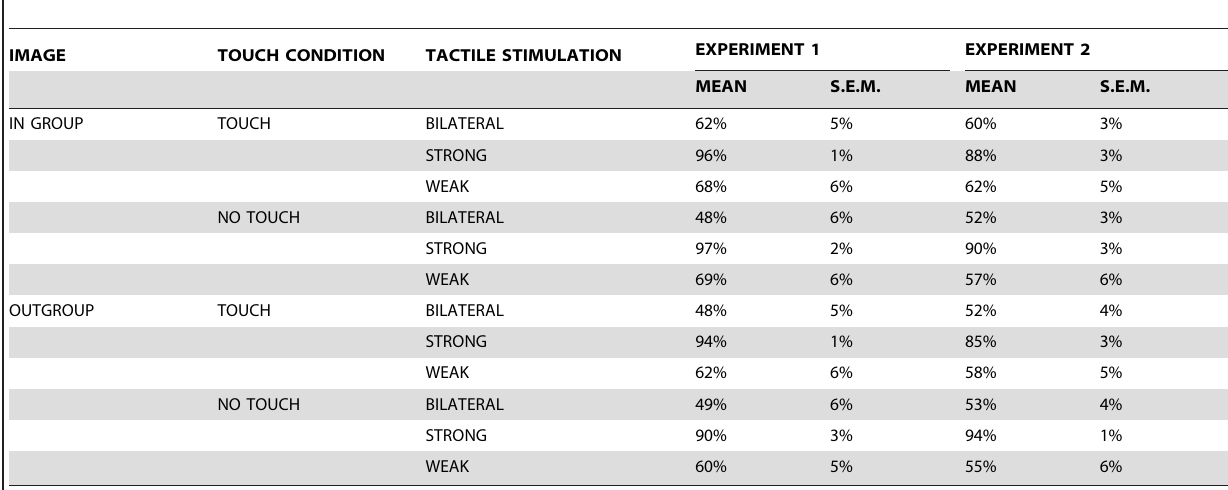
Table 1. Mean accuracy and s.e.m. for the three types of tactile stimulation when viewing In-group and Out-group faces being touched, or not being touched, in Experiment 1 and Experiment